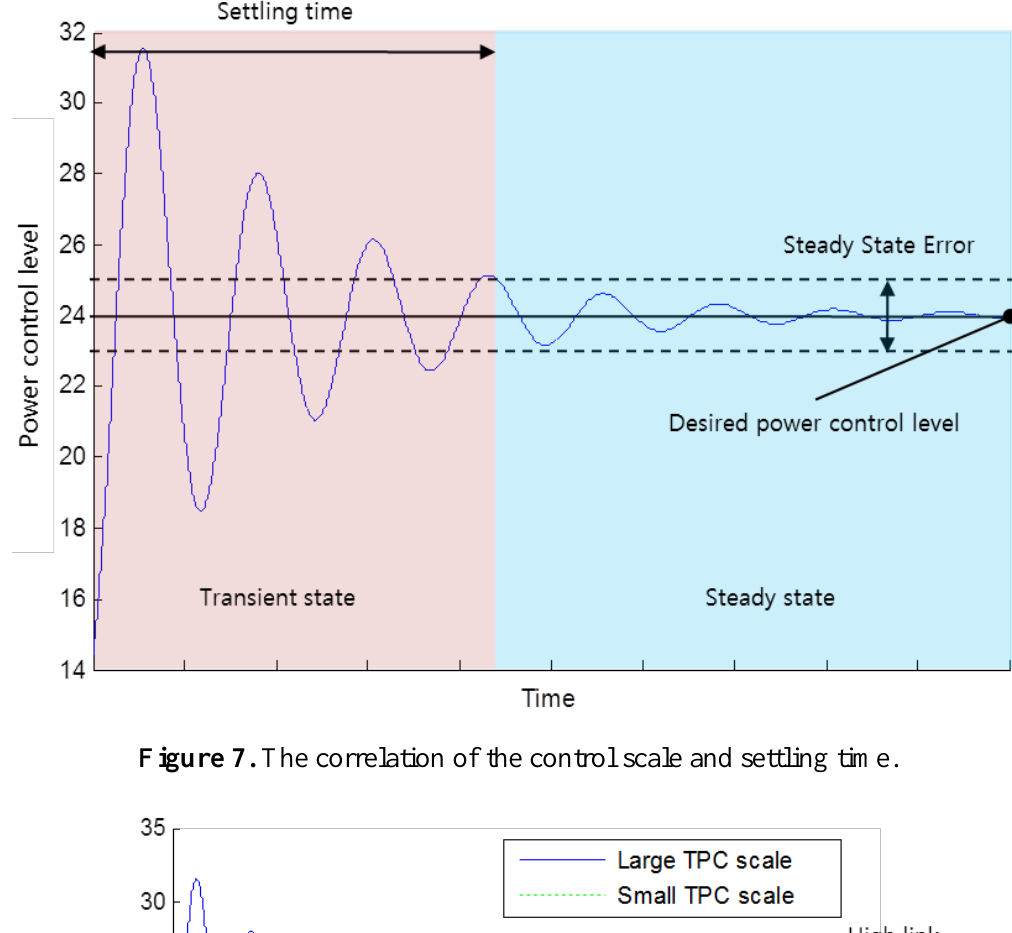
Figure 6. The transient state and steady state.